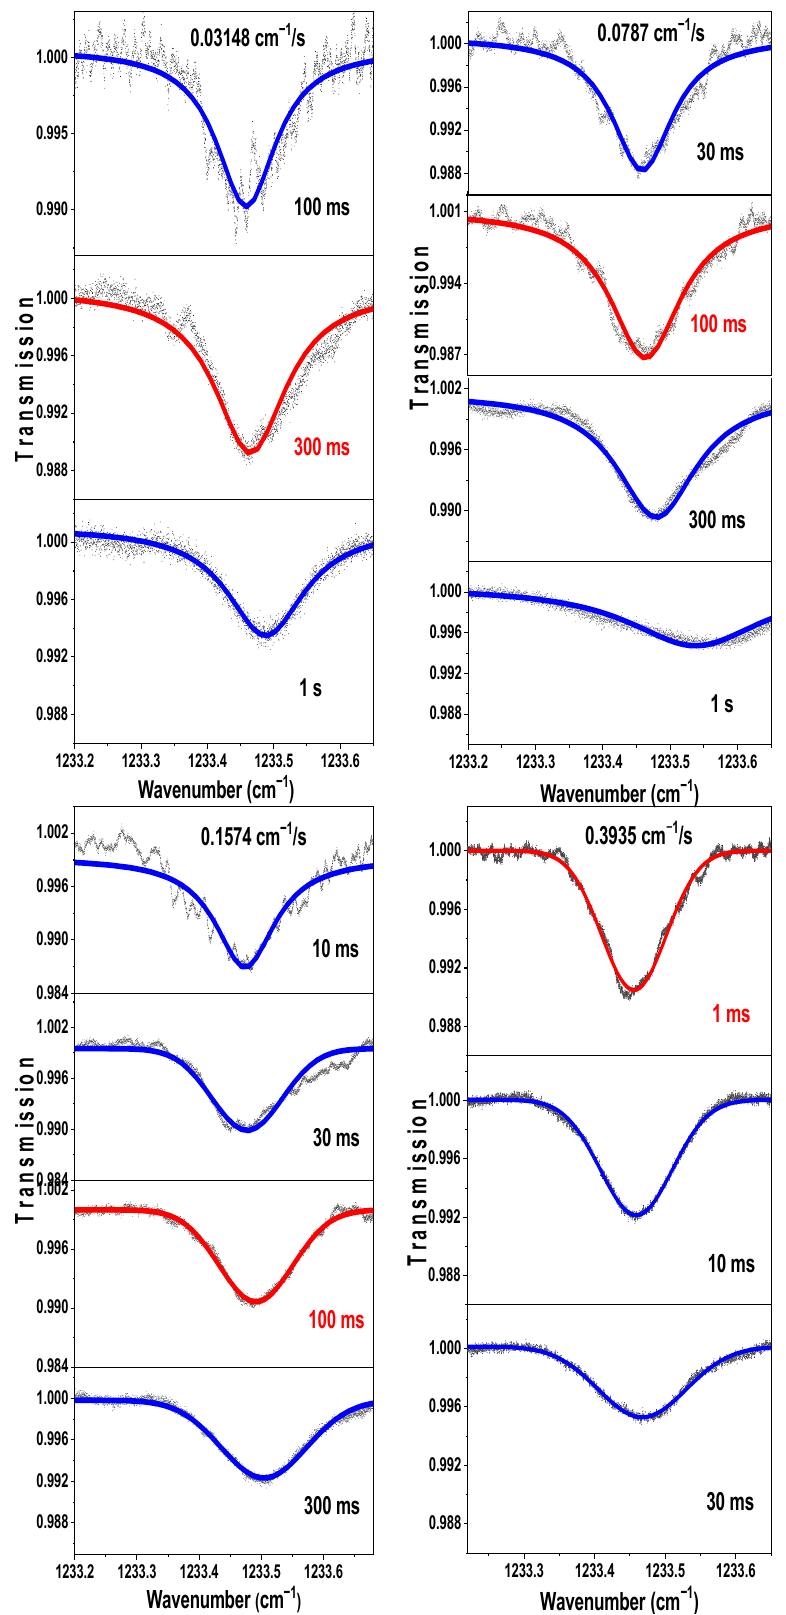
Figure 6. BB-based heterodyne spectra of CH 4 absorption at different scanning speed ( υ sc ) (i.e., different given scanning time Δ T scan ) combined with different time constants ( τ ), respectively. Line shape fits were performed using the Lorentz profile ( red or blue ).